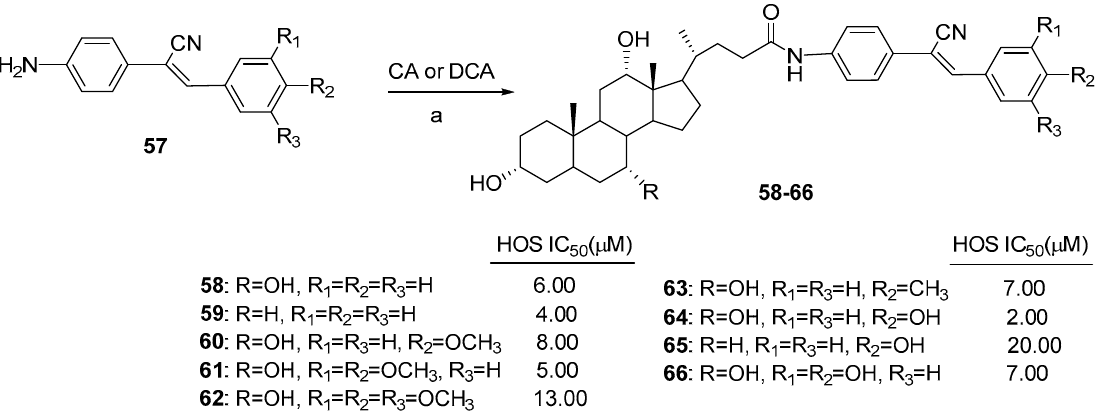
Scheme 9. Synthesis of α -cyanostilbene hybrids. Reaction condictions: (a) EDC, HCl/HOBt/Et 3 N, DMF, MW, 80 °C, 1 h (52–88% yields).